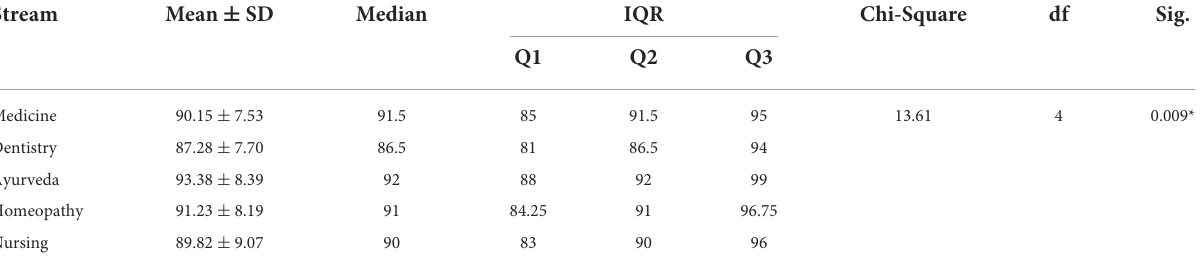
Table 2B Known group validity based on healthcare